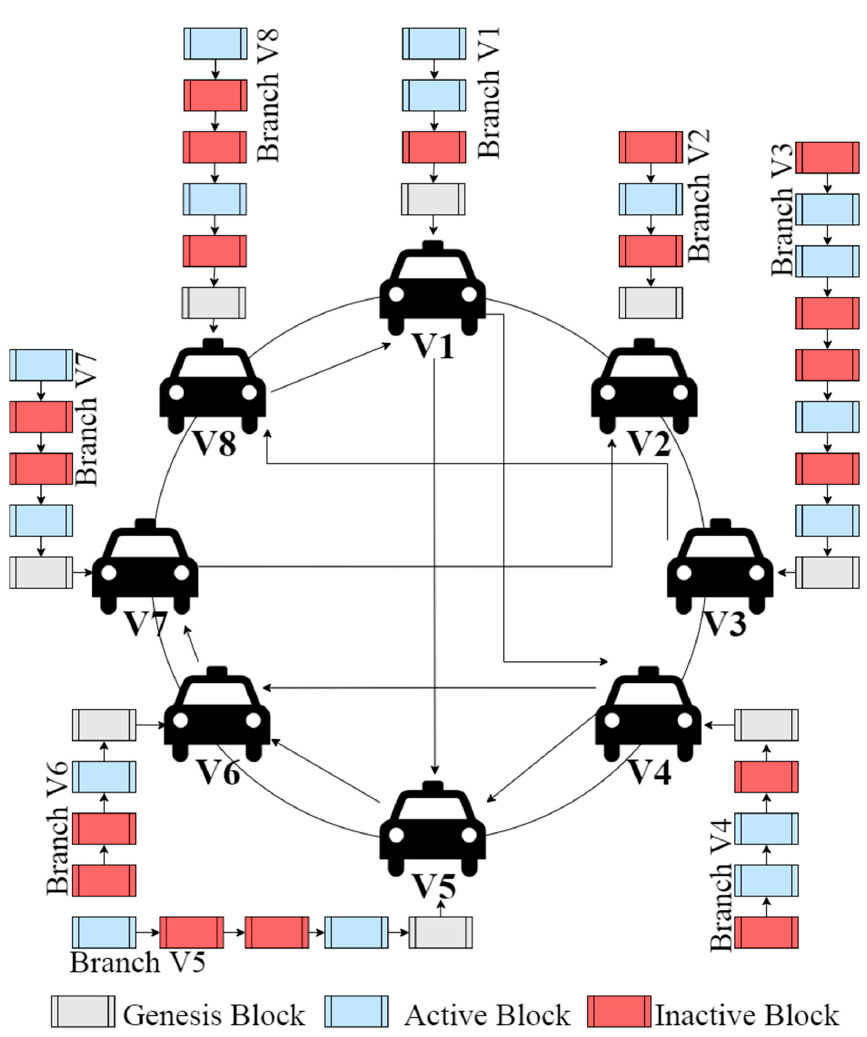
Figure 3. Branched Blockchain for Layer 1 Nodes.